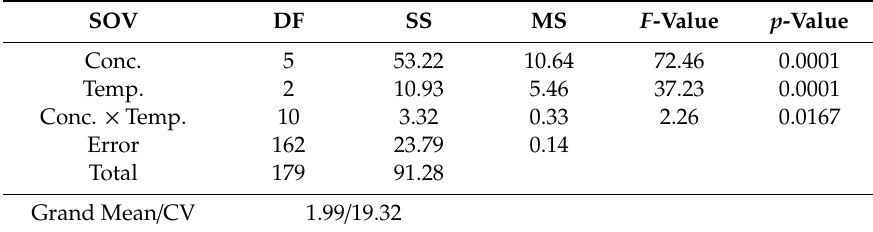
Table A7. Nymphal development time of 2nd instar ( M. persicae ) in relation to PeBL1 elicitor and temperature. SOV DF SS MS Conc. Temp. Conc. × Temp.